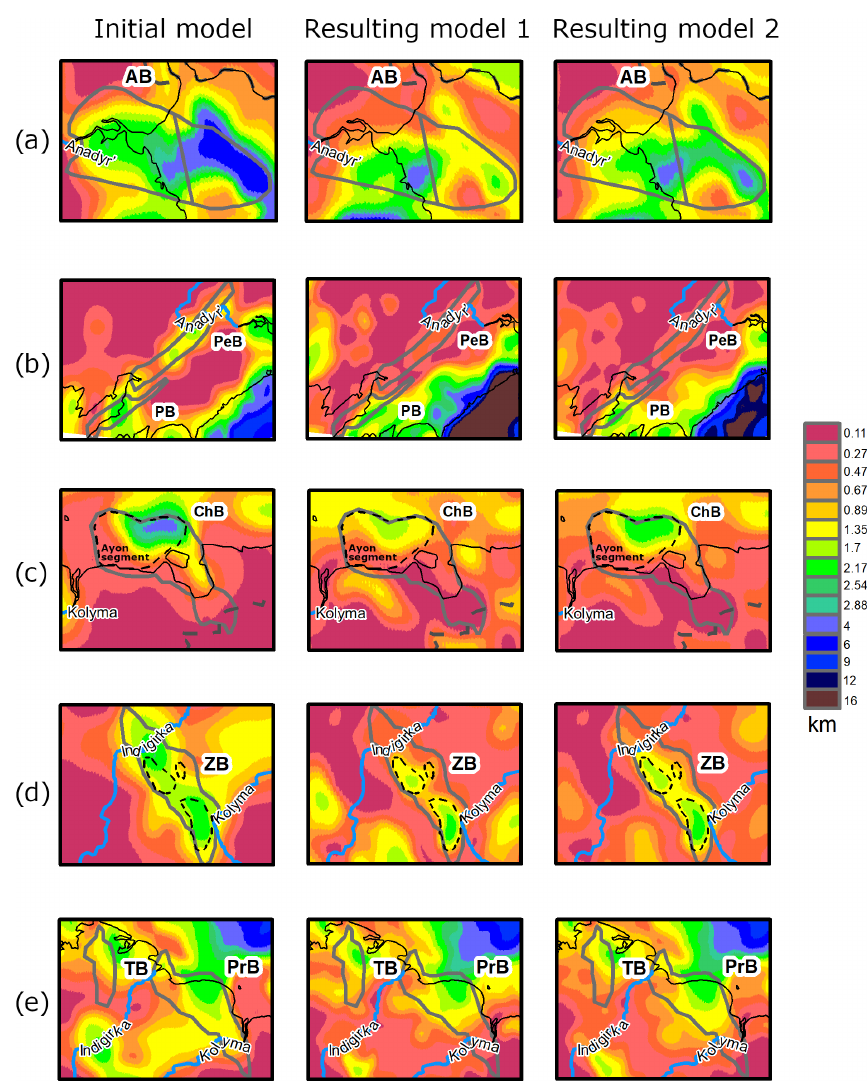
Figure 9. Comparison between the initial sedimentary model (left) and the new sedimentary cover models – 1 (centre) and 2 (right) – for several basins: Anadyr (a) , Penzhin and Pustorets (b) , Chauna (c) , Zyryanka ( d , dashed lines show the Lower Cretaceous coal-bearing zones), Primorsk and Tastakh (e)